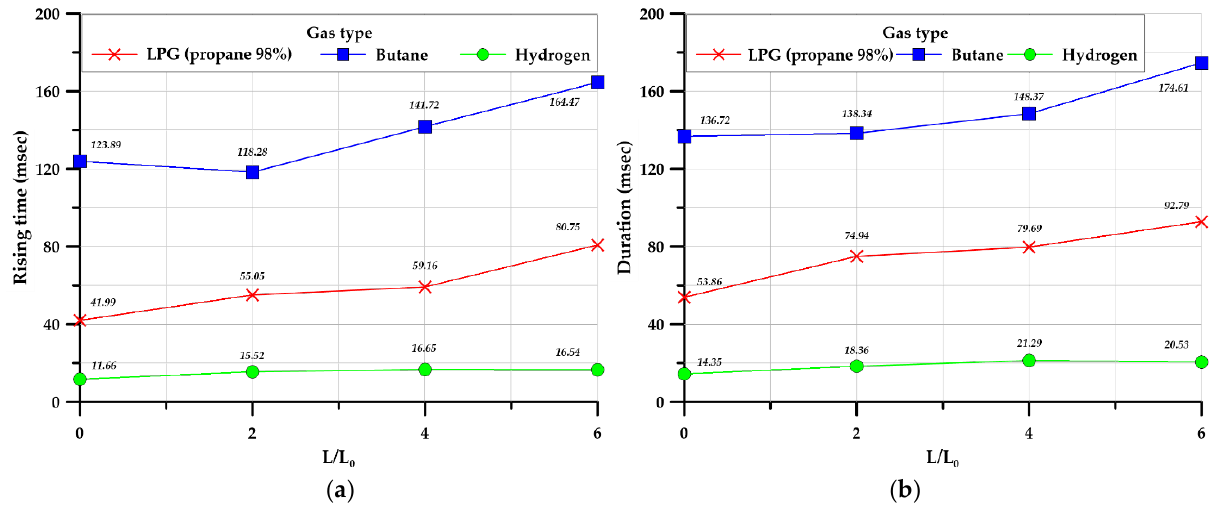
Figure 21. Average rising time ( a ) and duration ( b ) in the square-type chamber